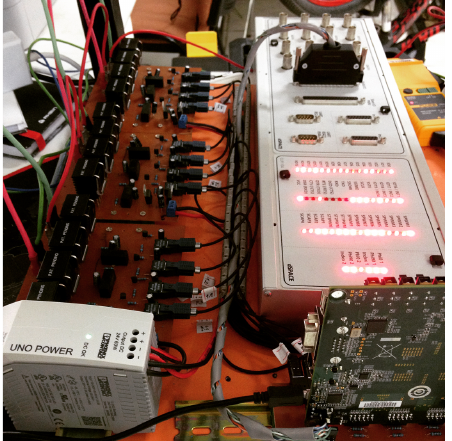
Figure 10. Implementation for a 27-level asymmetric multilevel